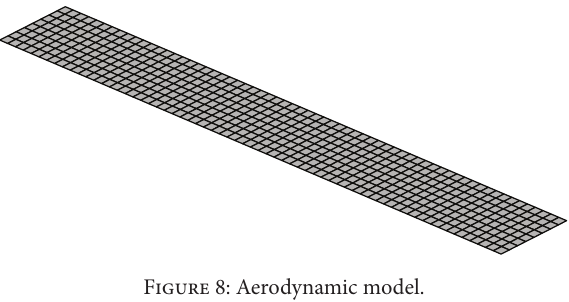
Figure 8: Aerodynamic model.